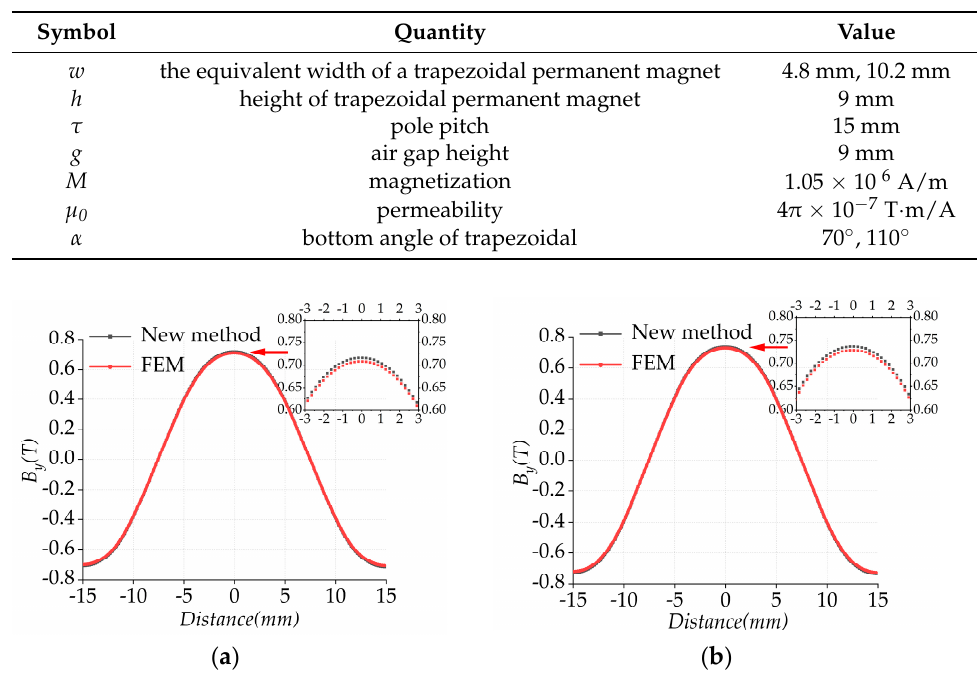
Figure 4. Comparison of the improved equivalent surface current method and the fi nite element method results for the single-period air gap’s center magnetic fi eld: ( a ) α = 70°, and ( b ) α = 110°.